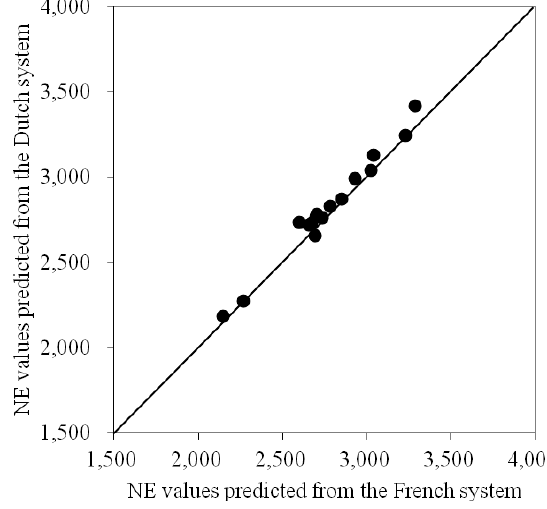
Figure 3. Comparison of predicted NE values (kcal/kg) of 16 diets fed to finishing pigs from the French and Dutch NE system (if the dots are placed on the center line, the predicted values are identical between 2